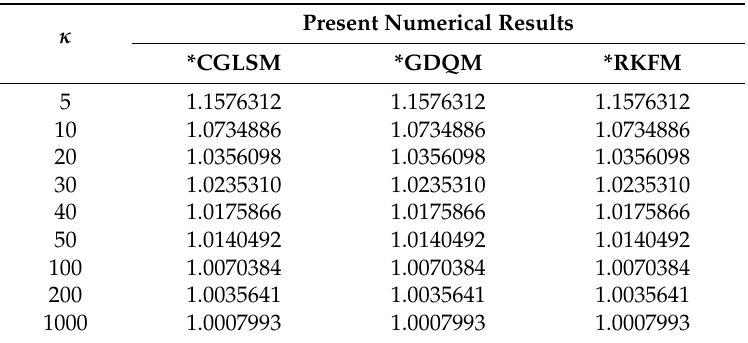
Table 4. Multiple comparison results for − Re 0.5 s Cf s , when φ = ε = Ec = M = 0, ξ ∞ = 10, and N = 29.